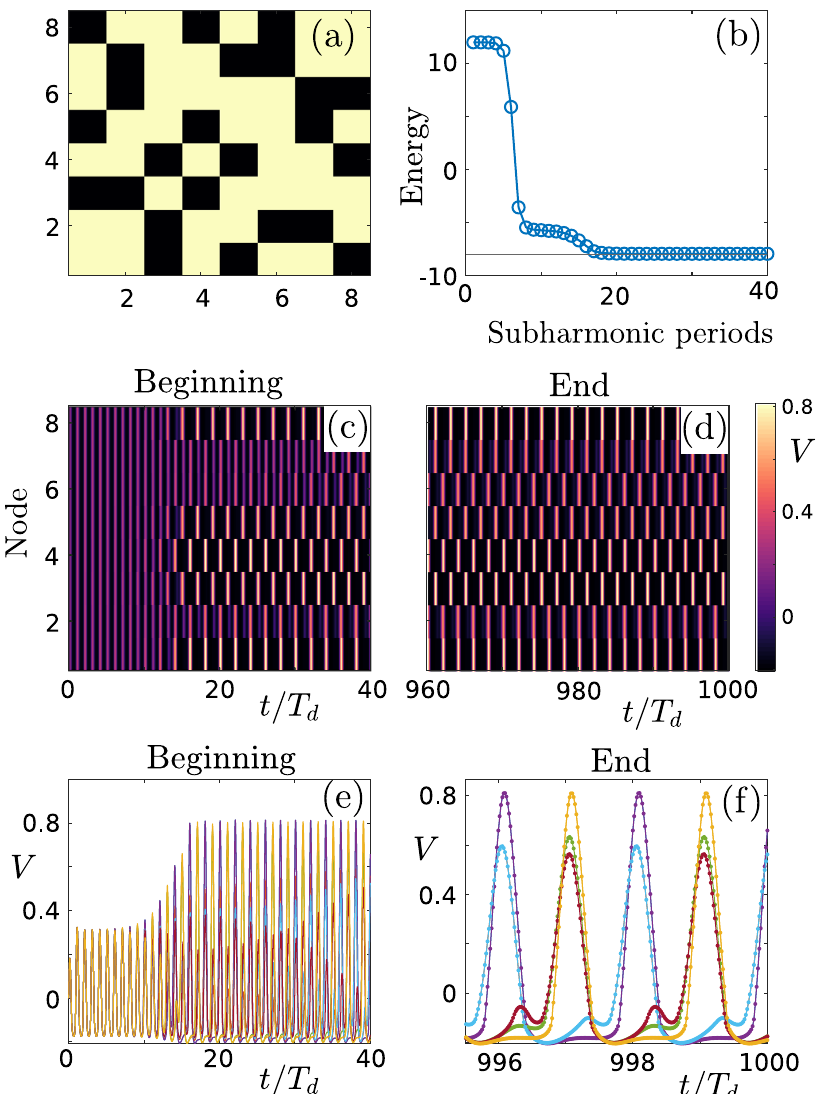
Fig. 7 Numerical Simulations. Simulation results corresponding to the experimental setup of Fig. 5. a 3-regular graph of N = 8 coupling matrix, b energy evolution of the network; we reach an approximate ground state of energy E ≈ − 8 after around 20 subharmonic periods. c , d Early and late circuit response, respectively. e , f Early and late time evolution of the voltage of the 8 oscillators starting from very small (~10 − 3 V) random initial conditions. The different colors represent different oscillators (4 in purple, 5 in green, 6 in light blue, 7 in maroon, and 8 in yellow). The time unit used is the driving period T d . The driving parameters used read ω d = 1.26 ω 0 and V d = 3.1